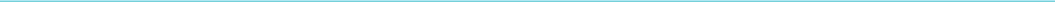
Figure 1: The basic working principle of major genome-editing technologies. Meganucleases are engineered restriction enzymes that recog- nise long stretches of DNA sequences. Each zinc finger nuclease recognises triple DNA code whereas each TALE recognises an individual base. Unlike protein-DNA recognition in ZFNs and TALENs, simple RNA-DNA base pairing and the PAM sequence determine CRISPR target- ing specificity. All these tools result in DNA double-strand breaks, which are repaired either by error-prone non-homology end joining or homol- ogy-directed repair. While NHEJ results in random indels and gene disruption at the target site, HDR can be harnessed to insert a specific DNA template (single stranded or double stranded) at the target site for precise gene editing.Reproduced from Adli M. The CRISPR tool kit for genome editing and beyond. Nat Comm 2018; 9(1):1911. doi: 10.1038/s41467-018-04252-2, with permission; © Nature Publishing Group